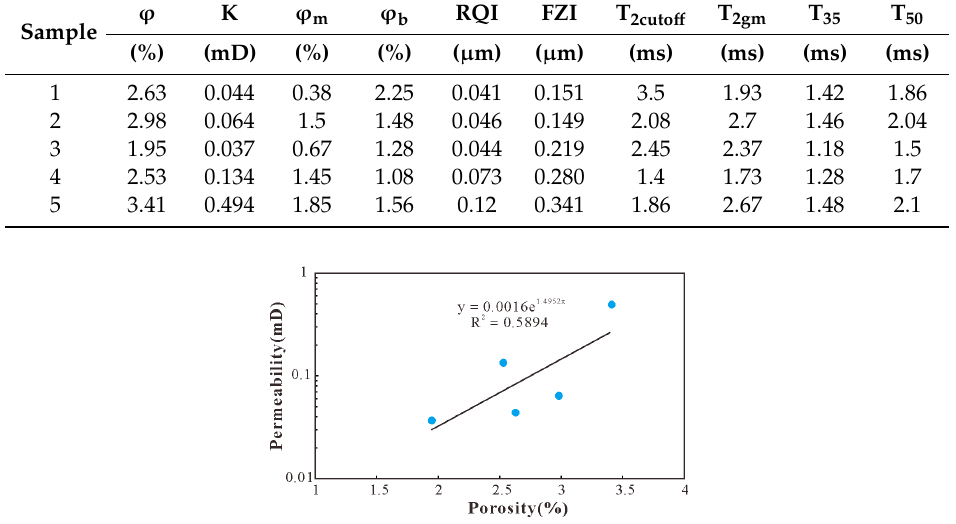
Table 2. The petrophysical parameters and pore structure parameters of the tight sandstone samples from NMR measurements.